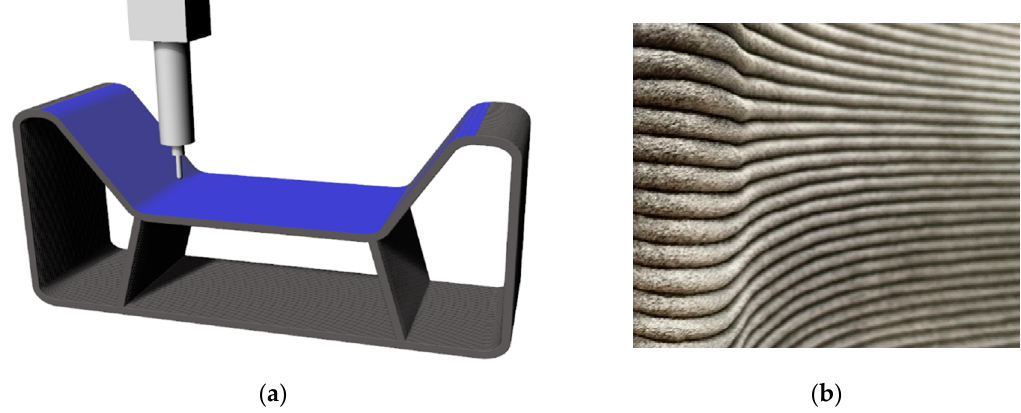
Figure 5. The cavity needs to be prepared in the following step: illustration of the fine finishing process ( a ); lines of extruded granulate before the finishing process to smoothen the surface ( b ).